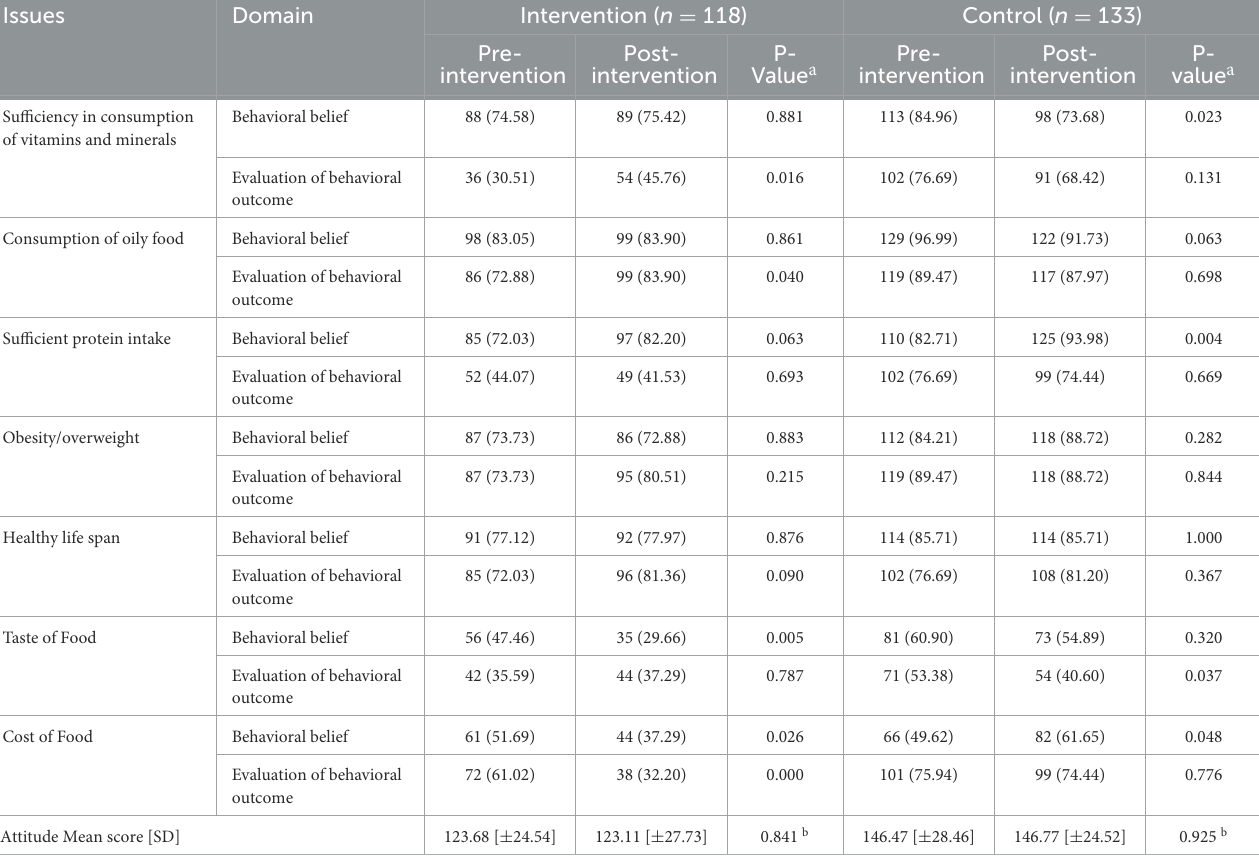
TABLE 3 Pre- and post-intervention comparison of attitudes regarding consumption of healthy diet among intervention and control